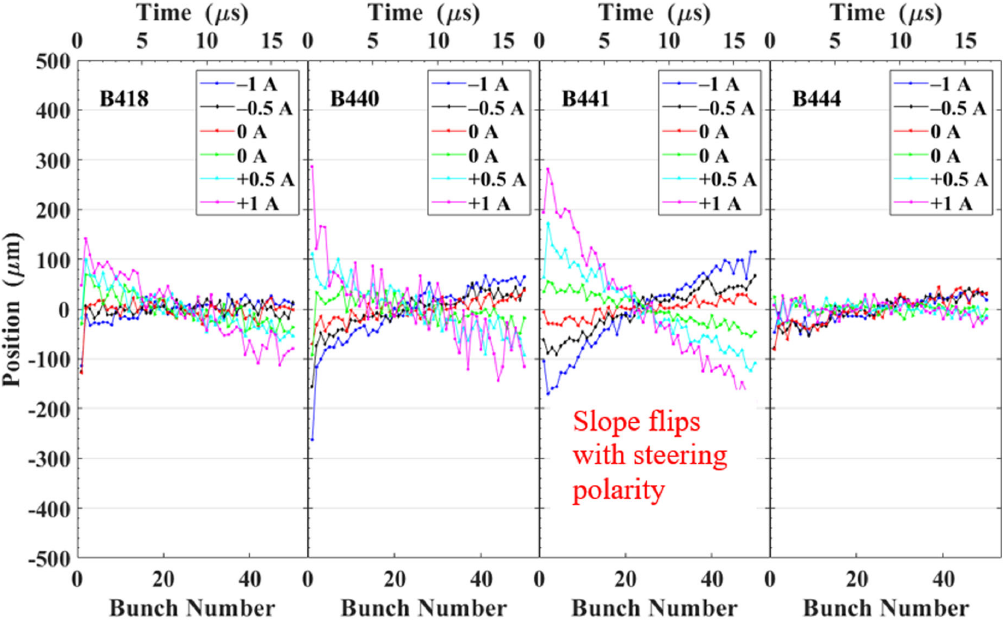
FIG. 7. Submacropulse vertical centroid effects using 300-shot averages in the first four BPM locations after CM2:C8 correlated with V125 settings. This includes the cold BPM denoted B418. The array mean value was subtracted for each curve to make direct comparisons easier. The z-locations are shown in Table III with the maximum centroid slewing seen in B441. The V125 corrector steering angle change is 2 mrad = A.